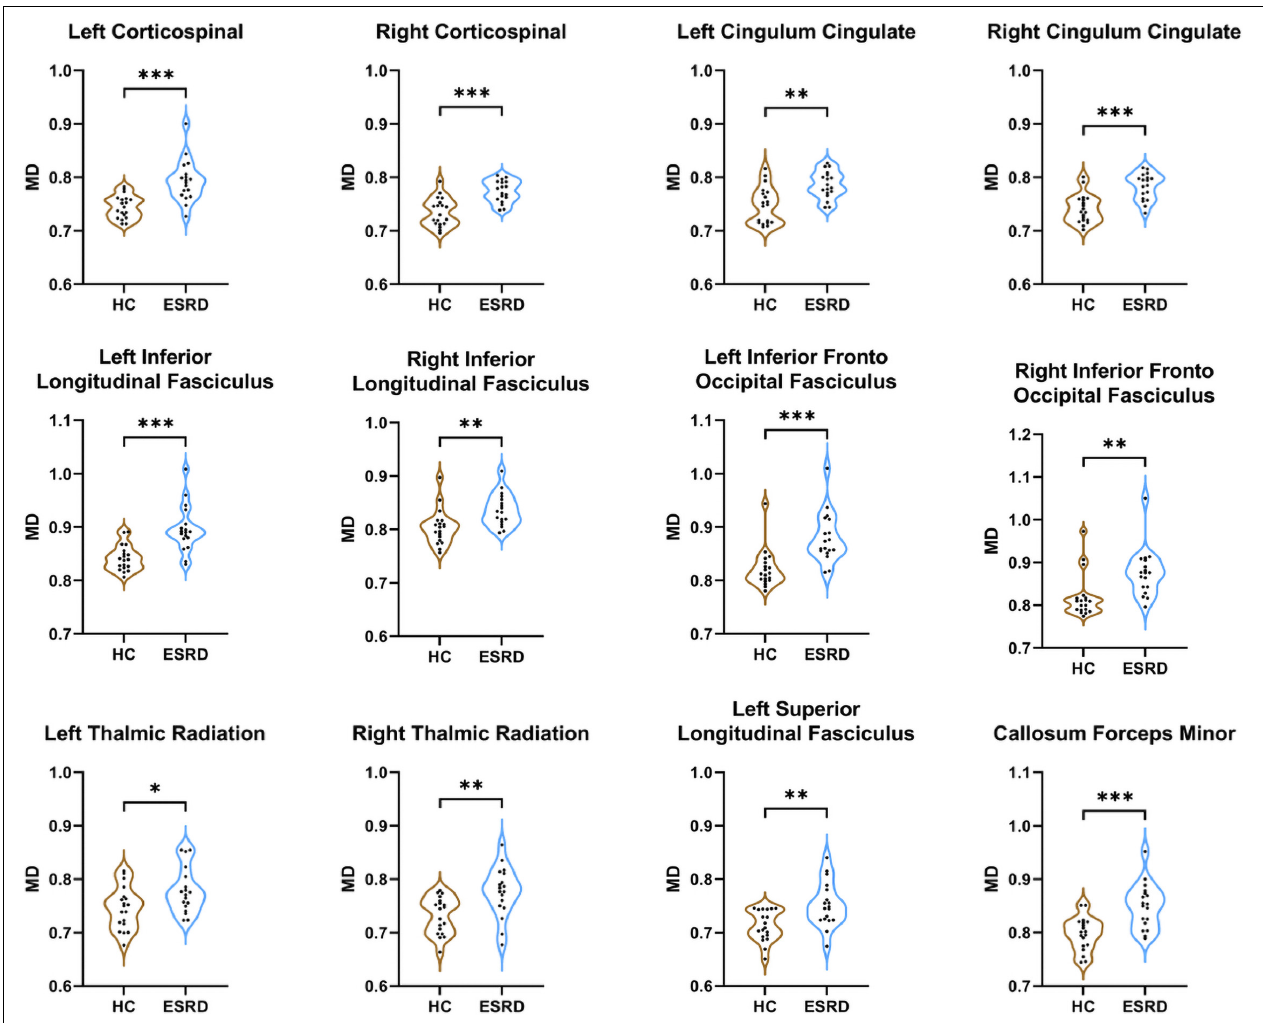
FIGURE 4 | Fibers with statistical differences in mean MD values between HCs and ESRD patients. * P < 0.05, ** P < 0.01, *** P <